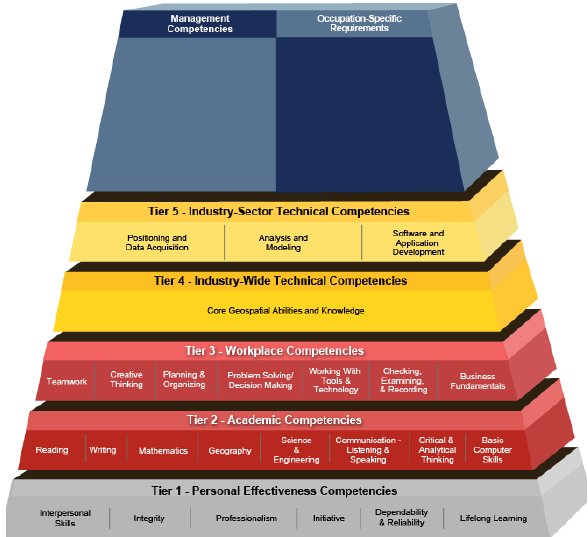
Figure 1: US-Geospatial Technology Competency Model (Source: Careeronestop,